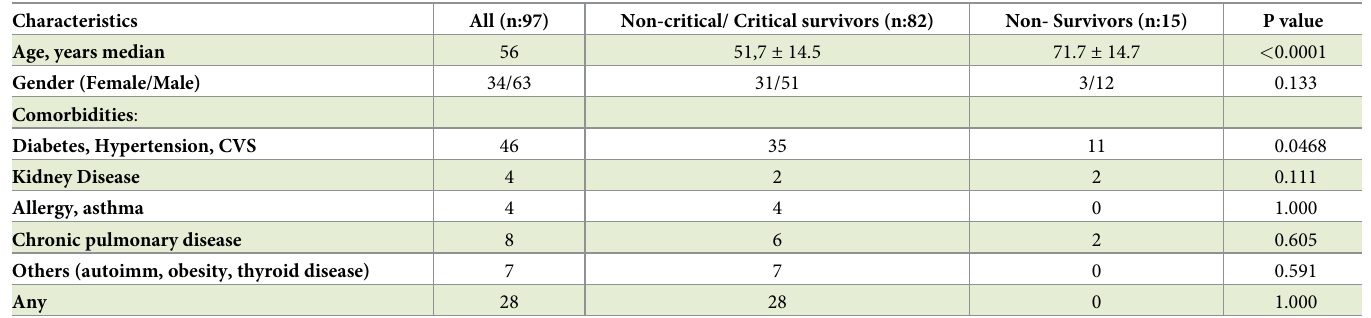
Table 1. Demographics of COVID-19